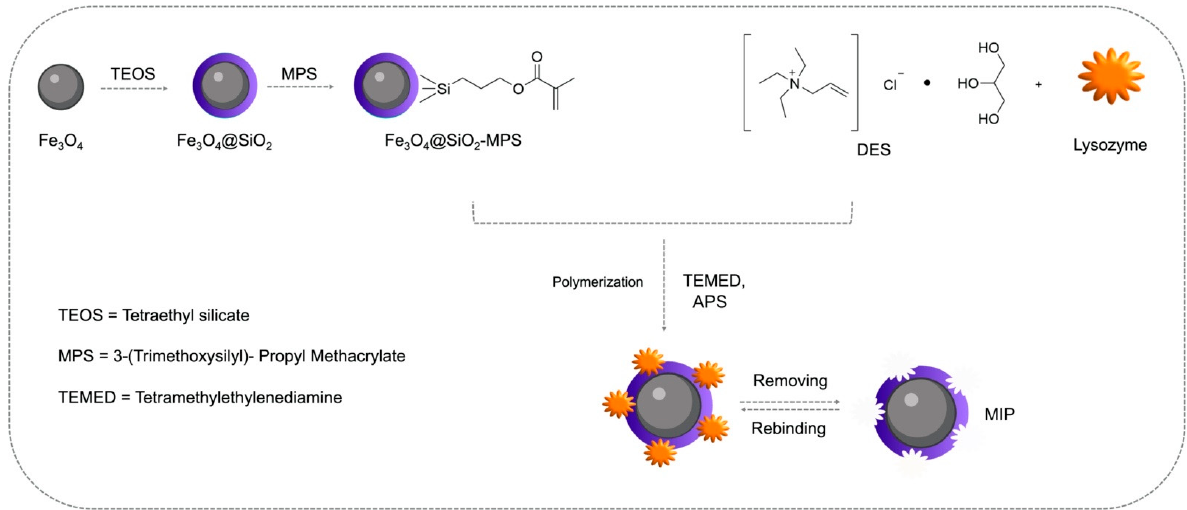
Figure 5. Schematic illustration of the preparation of DES ‐ Fe 3 O 4 @SiO 2 ‐ MIP. Adapted with permission from [45].